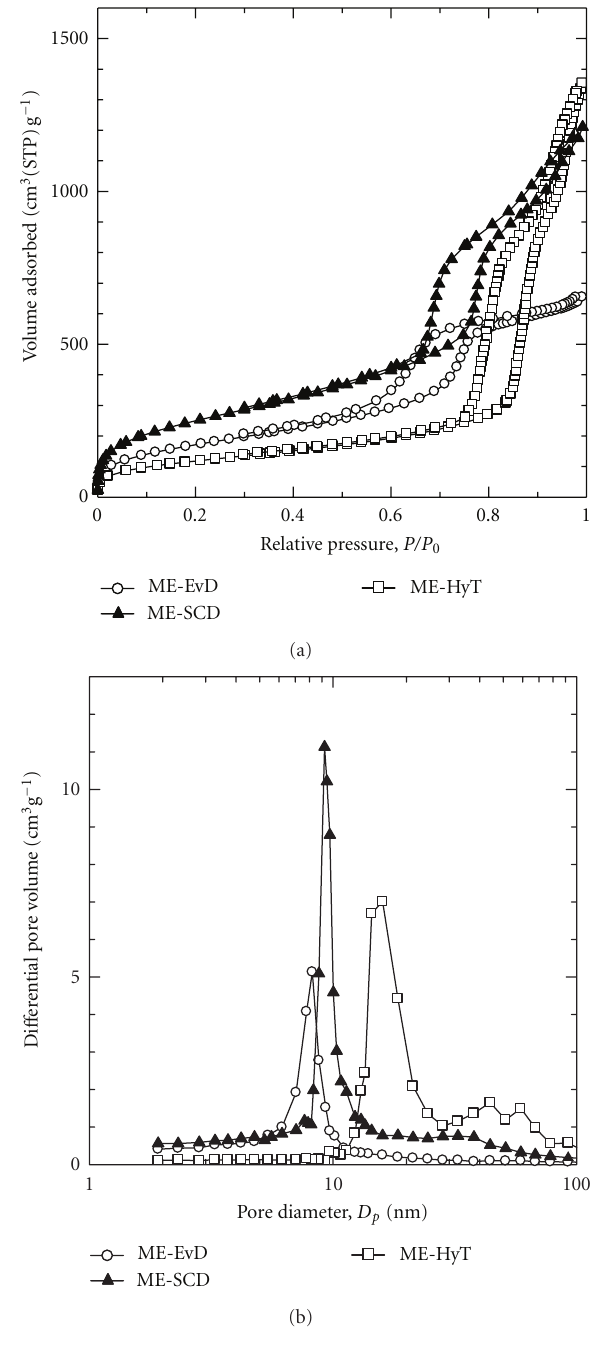
Figure 3: Adsorption-desorption isotherms (a) and di ff erential pore size distributions (b) of the ME-EvD, the ME-SCD, and the ME-HyT